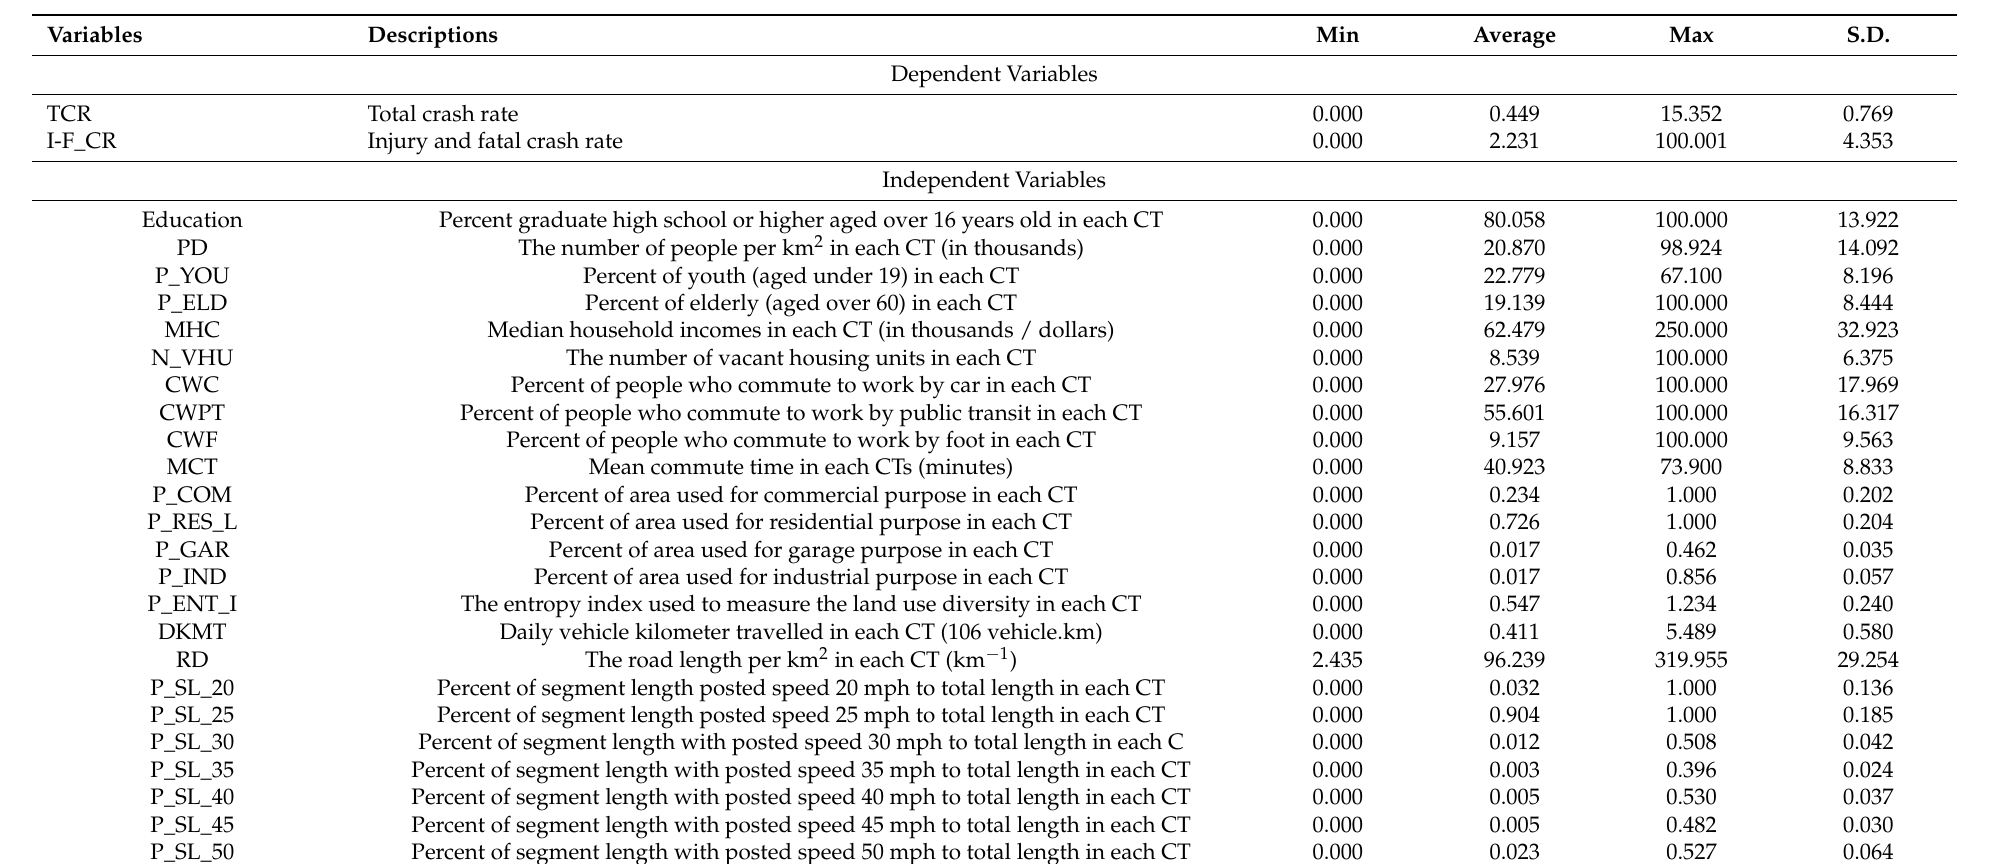
Table 1. Variables explanation and